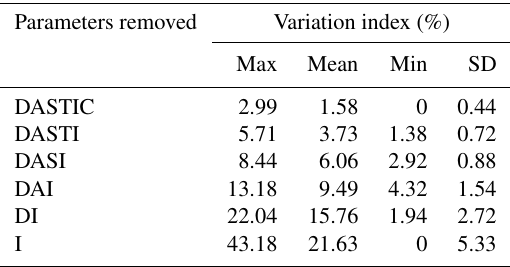
Table 11. Map removal sensitivity analysis (one or more parameters are removed at